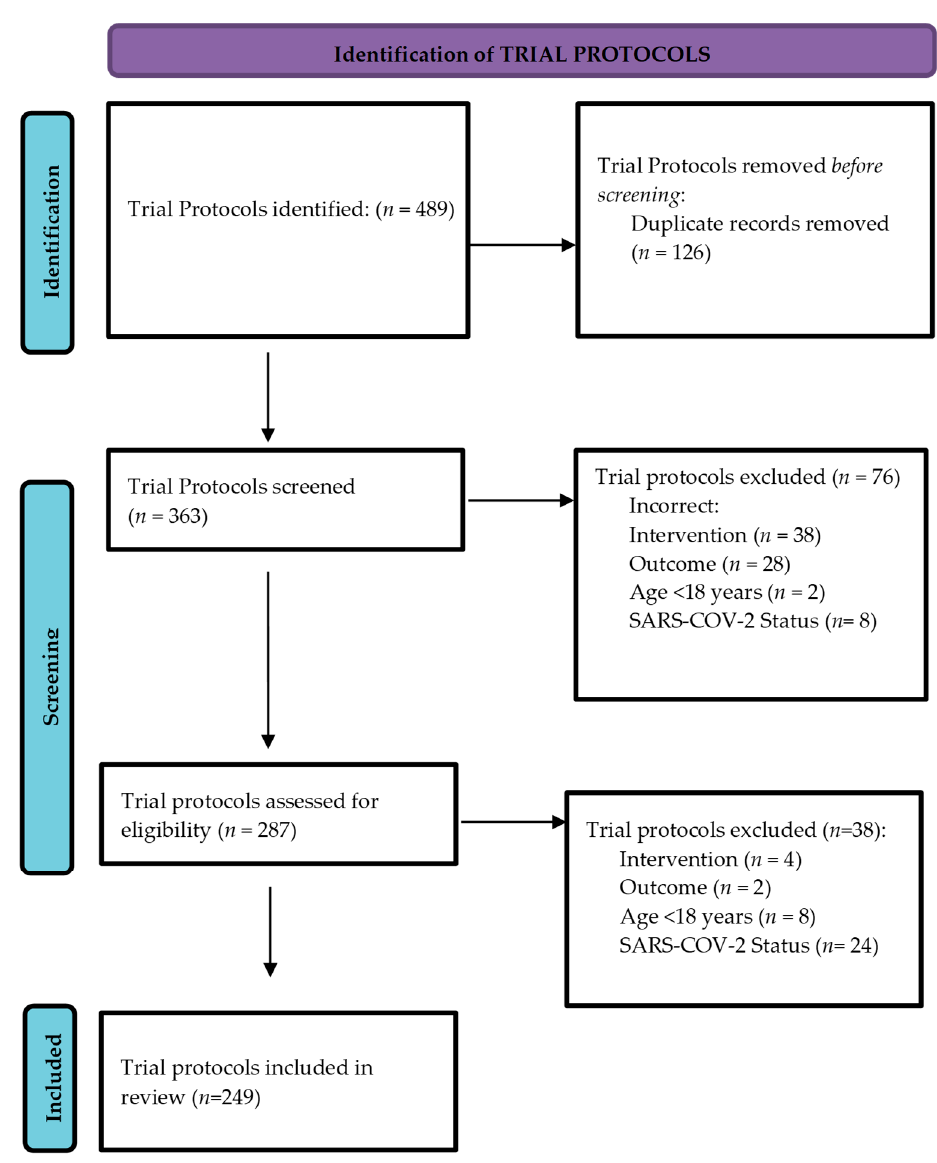
Figure 1. Identification of protocols for inclusion in review.